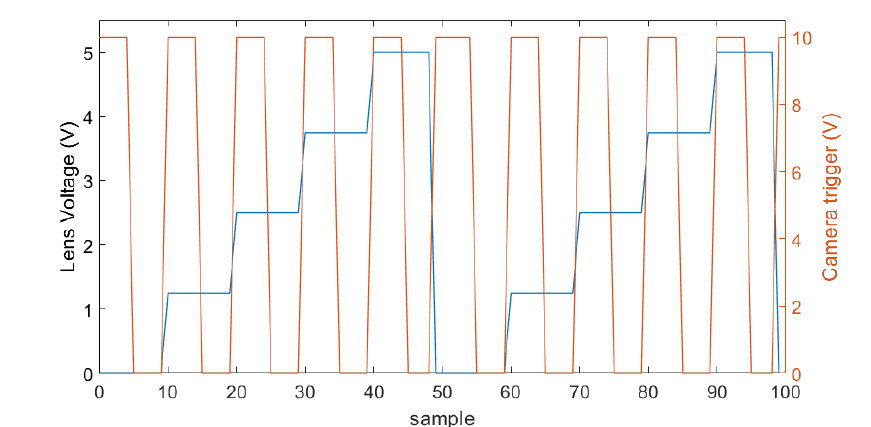
Figure 4. An example of a trigger signal to the camera (right axis, orange) on top of the analog staircase signal to the tunable lens (left axis, blue). The camera is triggered on the falling slope, which in itself is approximately in the center of the voltage step of the tunable lens. This example would capture 5 frames at 5 different focus distances two